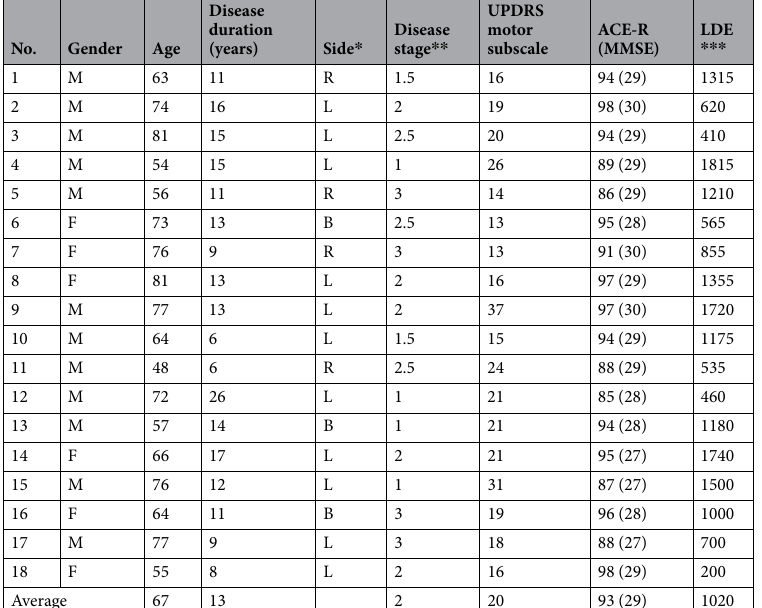
Table 1. Summary of patient clinical information. UPDRS = Unified Parkinson’s Disease Rating Scale; MMSE = Mini-Mental State Examination; ACE-R = Addenbrooke’s Cognitive Examination Revised; LDE = Levodopa dose equivalent; * Dominant side of motor symptoms: L = left, R = right, B = bilateral. ** According to Hoehn and Yahr, 1967; *** Calculated according to Tomlinson et al . 29